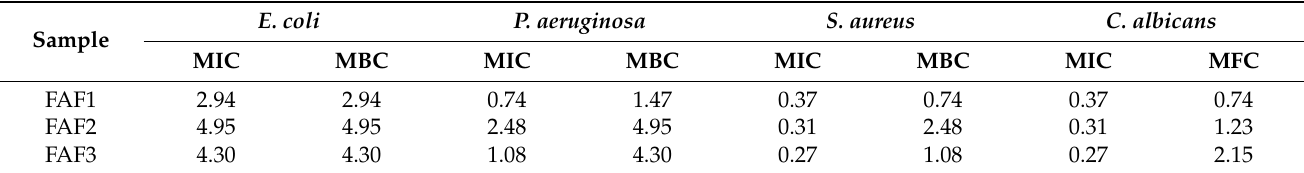
Table 6. Minimum inhibitory concentrations (MIC), minimum bactericidal (MBC), and